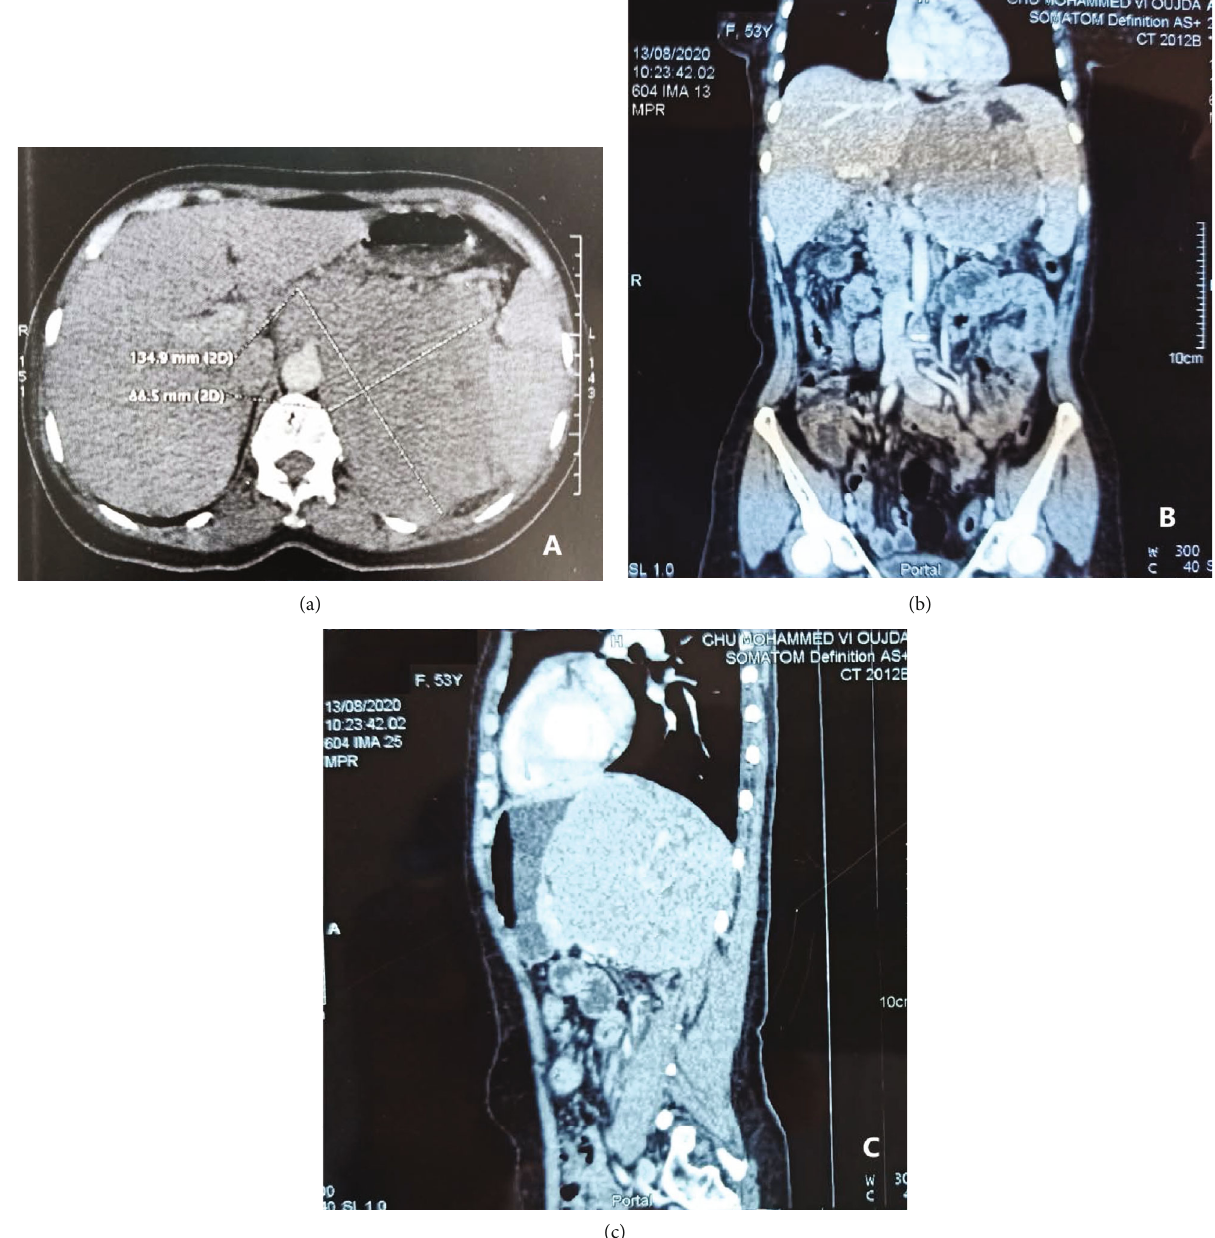
Figure 1: Abdominal CT scan: (a) axial, (b) frontal, and (c) sagittal images show the reports of the locally advanced left adrenal mass of 13.5cm long